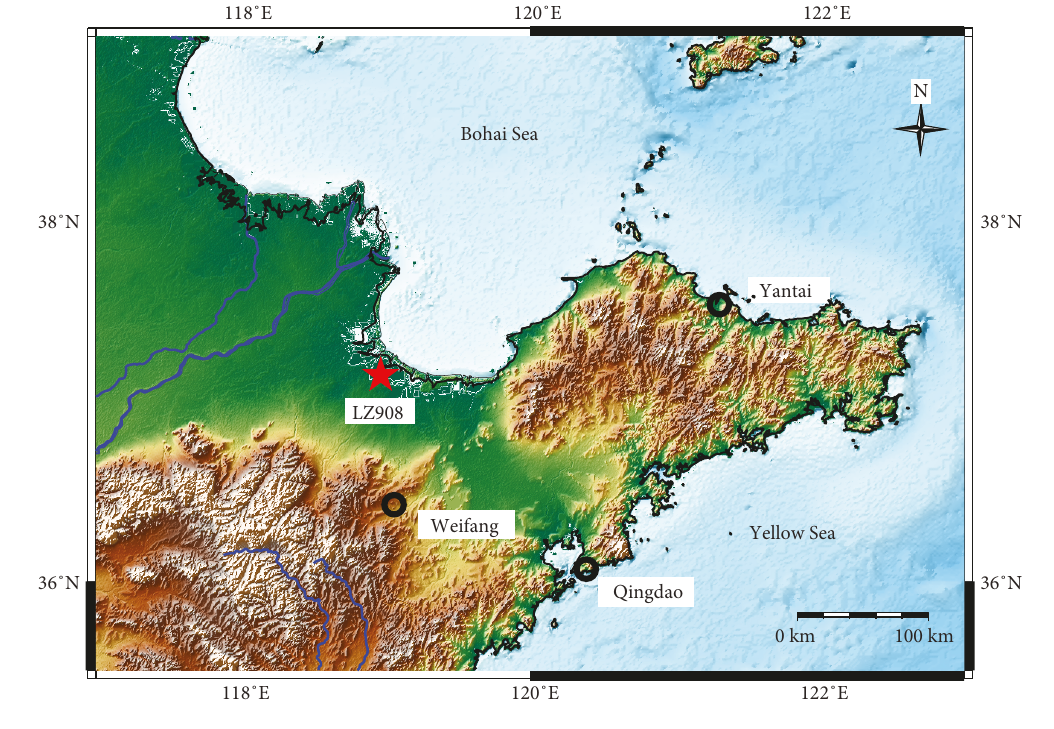
Figure 1: The location of borehole Lz908. Table 1: The dataset of “ Sediment/Grain-Size ” in the borehole Lz908. Depth of top